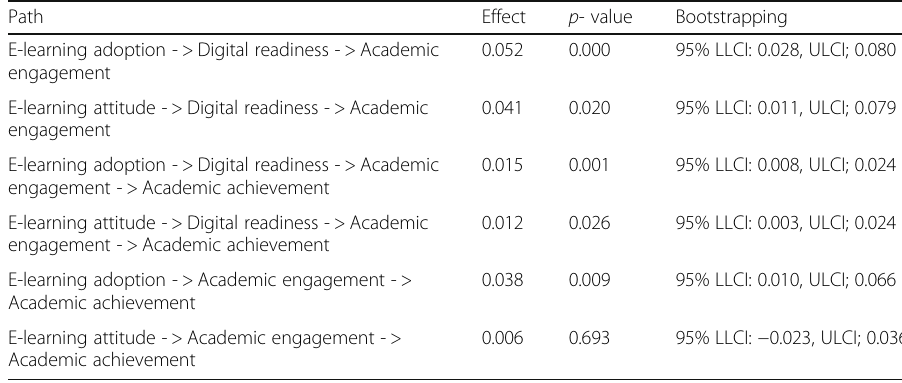
Table 6 Mediation effects Path Effect p - value